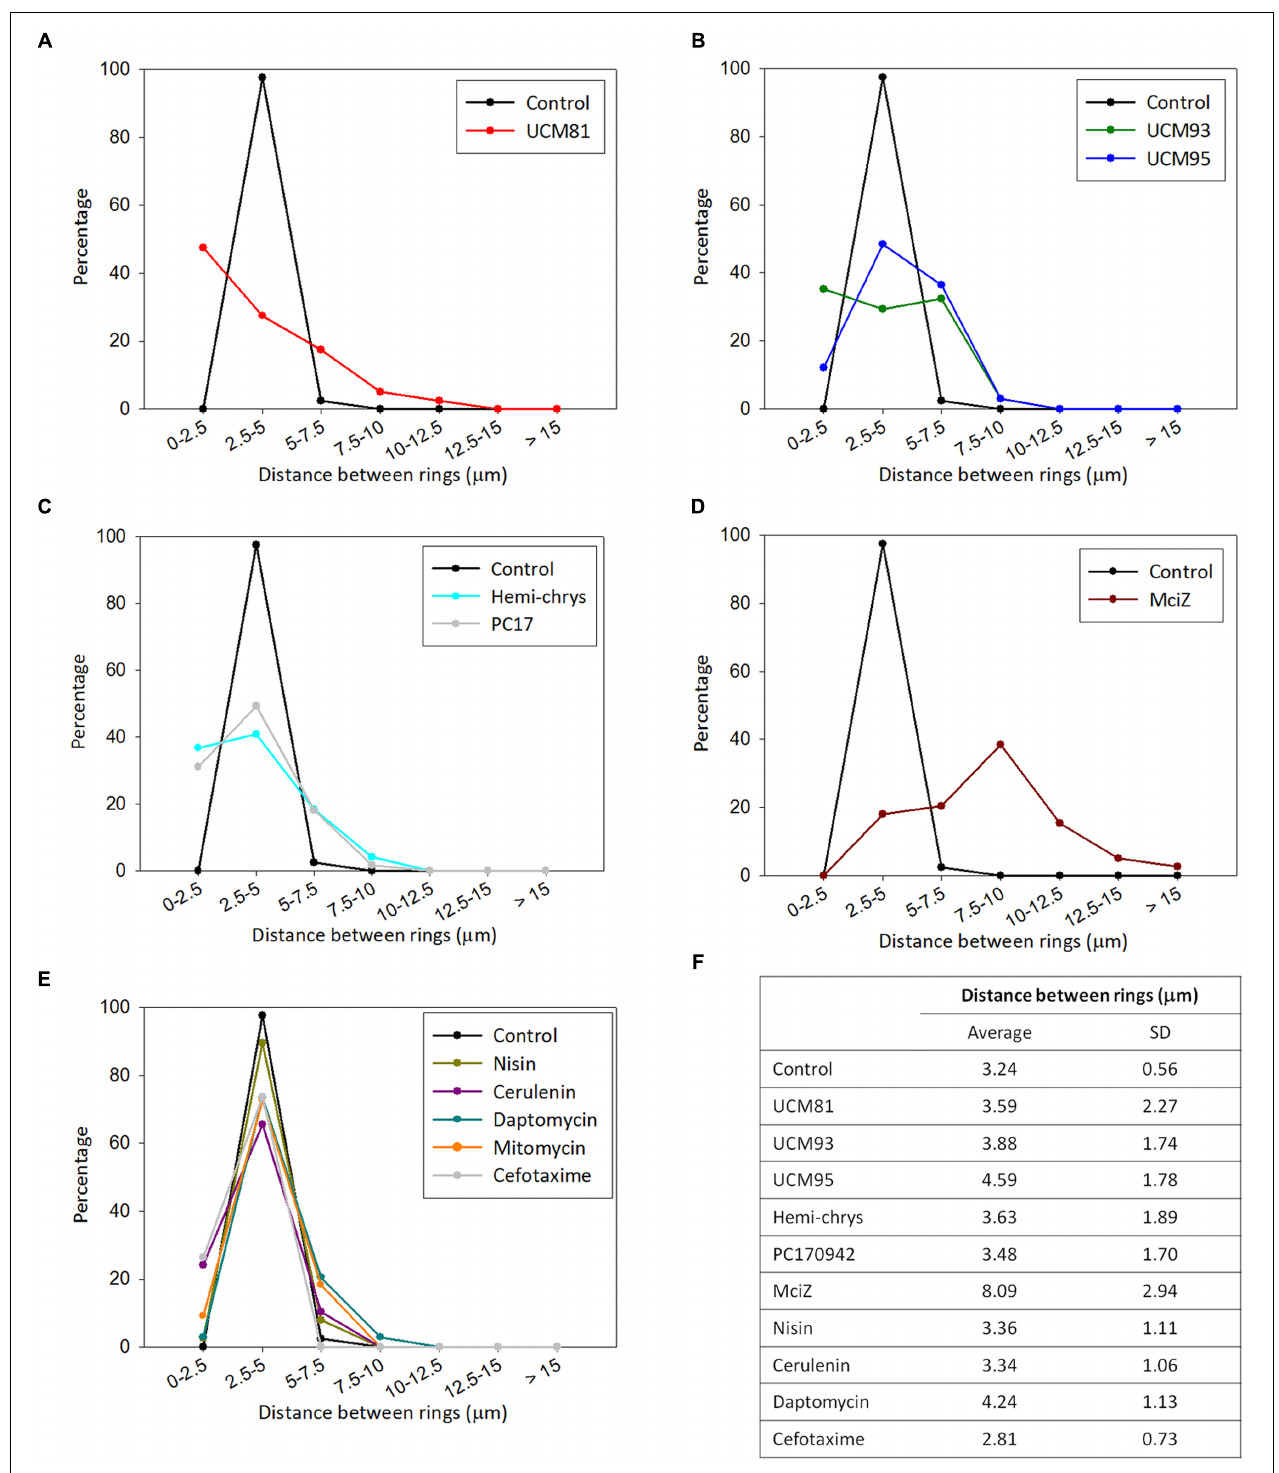
FIGURE 5 | Distribution of Z-rings along the cell. (A-E) The distance between pairs of consecutive rings in cells of B. subtilis SU570 exposed to the compounds were measured, classified in seven groups of distance (from 0 to 2.5 µ m, from 2.5 to 5 µ m, from 5 to 7.5 µ m, from 7.5 to 10 µ m, from 10 to 12.5 µ m, from 12.5 to 15 µ m, and more than 15 µ m) and the percentage of rings in each group were represented. (F) The average and standard deviation of the distance between rings are shown in the table to point out the spread of the